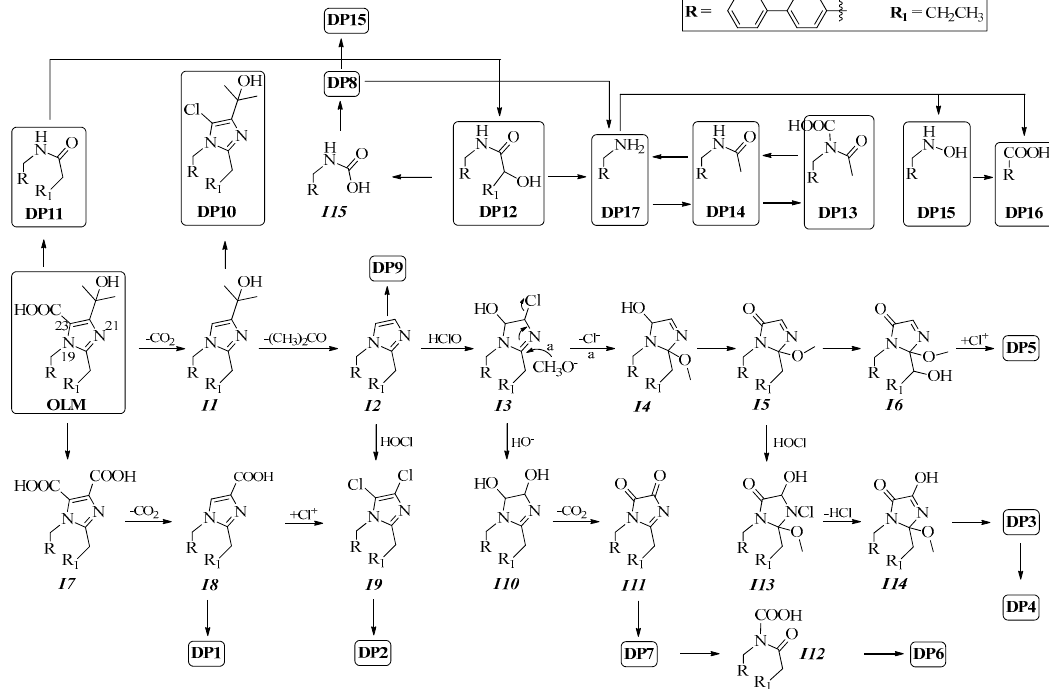
Figure 3. The plausible mechanism for the formation of DP1–DP17.